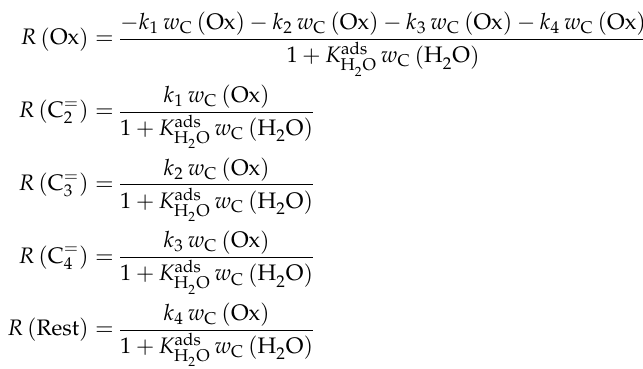
Scheme 30. Net rates of production of the different lumps for the model by Gayubo et al. [255] over SAPO-34 (five lumps); the Ox lump (methanol plus DME) is calculated via conservation of mass within the